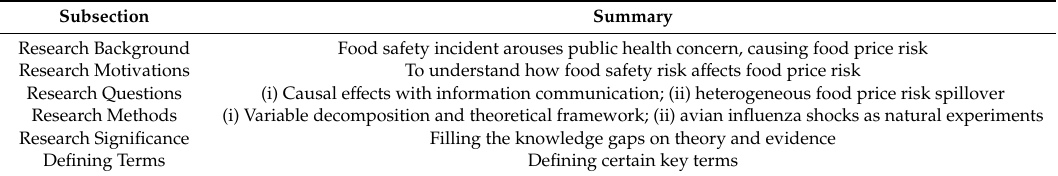
Table 1. Introduction